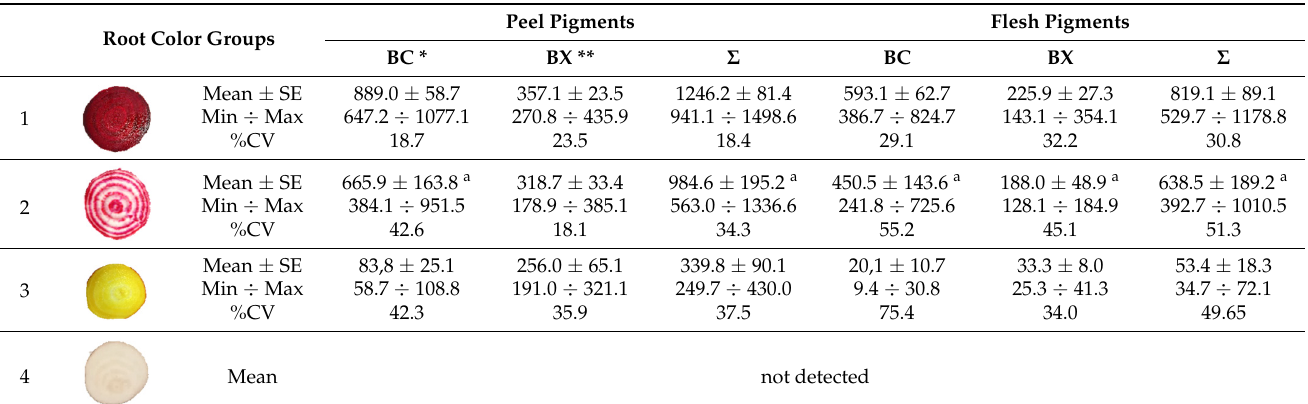
white roots, the pigment composition was not identified on the spectrophotometer. Table 2. Betalain content in the tested table beet accessions (mg/L FM). Duration of the growing Table 2. Betalain content in the tested table beet accessions (mg/L FM). Duration of the growing season: 105 days. Results are presented as mean values with a standard error (Mean ± SE). Values Table 2. Betalain content in the tested table beet accessions (mg/L FM). Duration of the growing season: 105 days. Results are presented as mean values with a standard error (Mean ± SE). Values Table 2. Betalain content in the tested table beet accessions (mg/L FM). Duration of the growing Table 2. Betalain content in the tested table beet accessions (mg/L FM). Duration of the growing were obtained from 10 roots of each season: 105 days. Results are presented as mean values with a standard error (Mean ± SE). Values were obtained from 10 roots of each accession. season: 105 days. Results are presented as mean values with a standard error (Mean ± SE). Values season: 105 days. Results are presented as mean values with a standard error (Mean ± SE). Values were obtained from 10 roots of each accession. were obtained from 10 roots of each accession. were obtained from 10 roots of each accession.